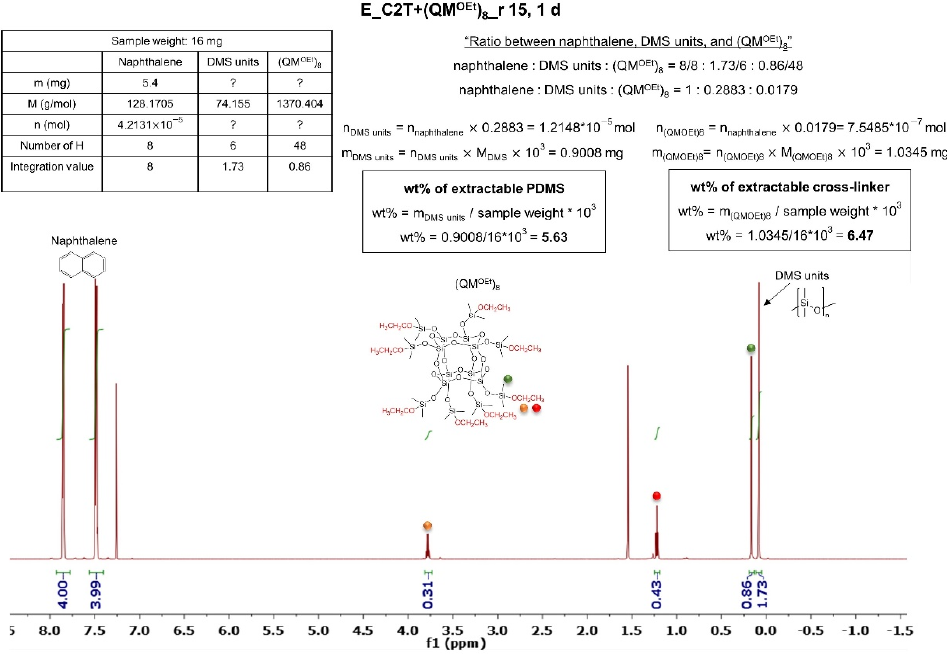
Figure A3. An example of calculation of the extractable PDMS from E_C2T+(QM H ) 8_ r15 after 1 day in a climate chamber.